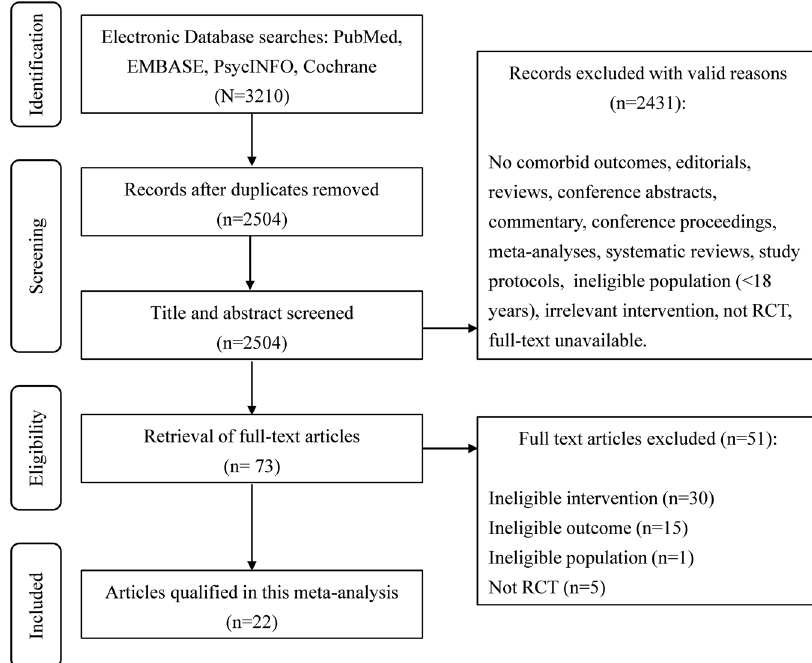
Fig. 1 PRISMA fl ow diagram. Search and study selection